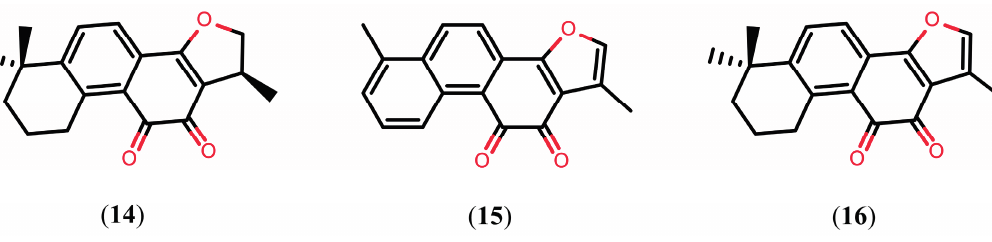
Figure 3. Chemical structures of